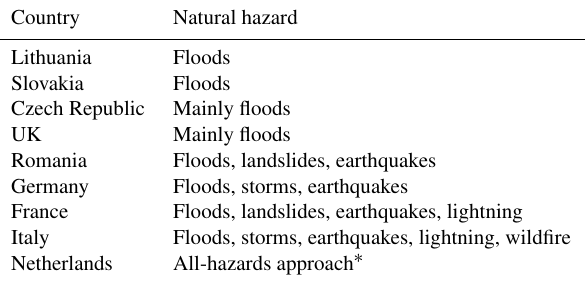
Table 1. Natural hazards considered in safety assessment and man- agement of process plants in the European Union (Krausmann and Baranzini, 2012).